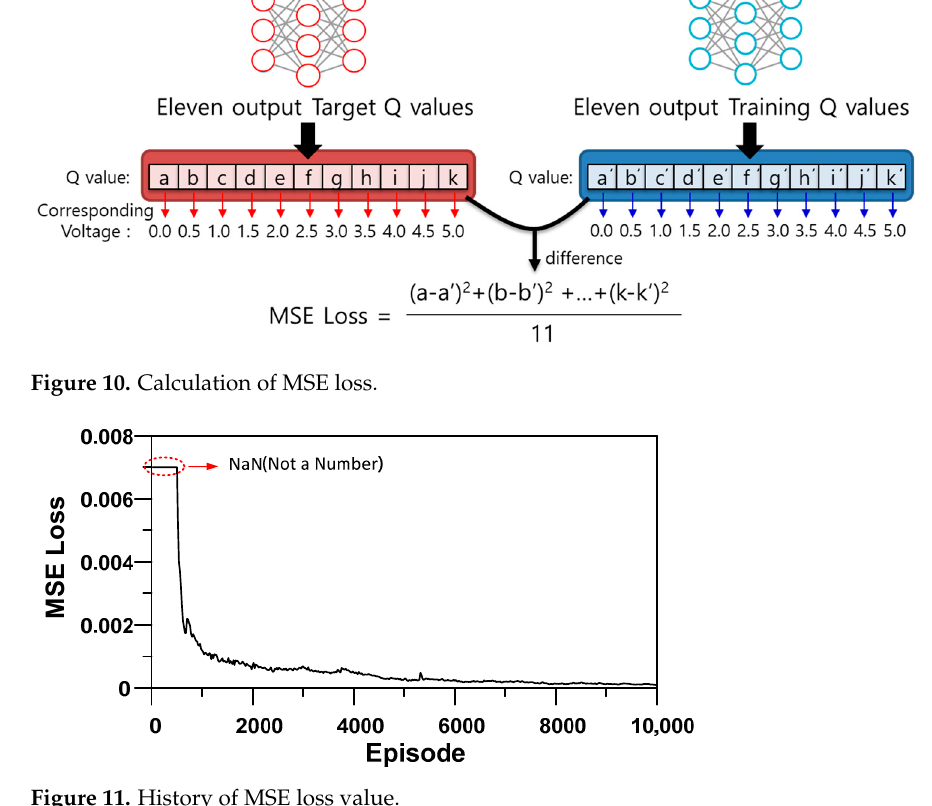
Figure 11. History of MSE loss value.